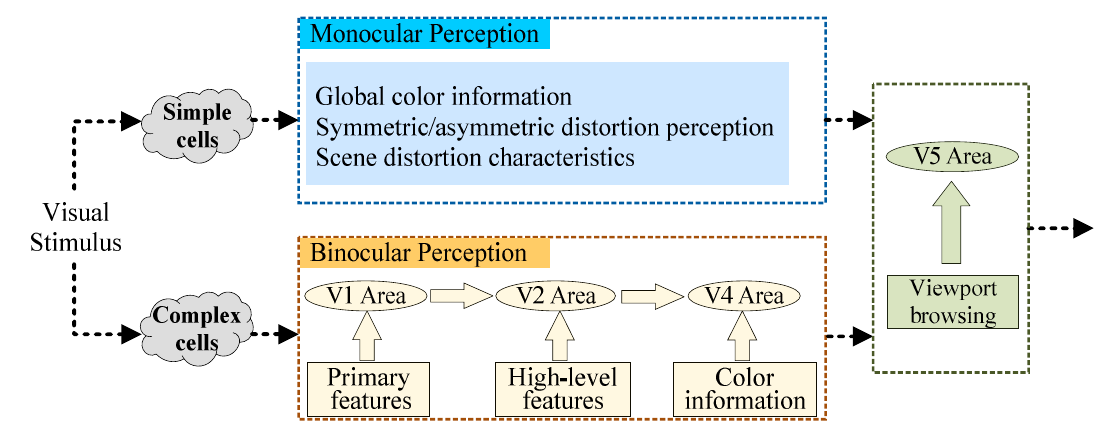
Figure 1. The visual perception process of user viewing HSOIs.